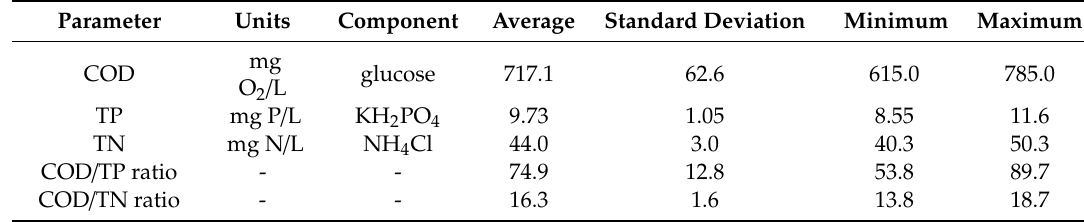
Table 5. Characteristics of synthetic